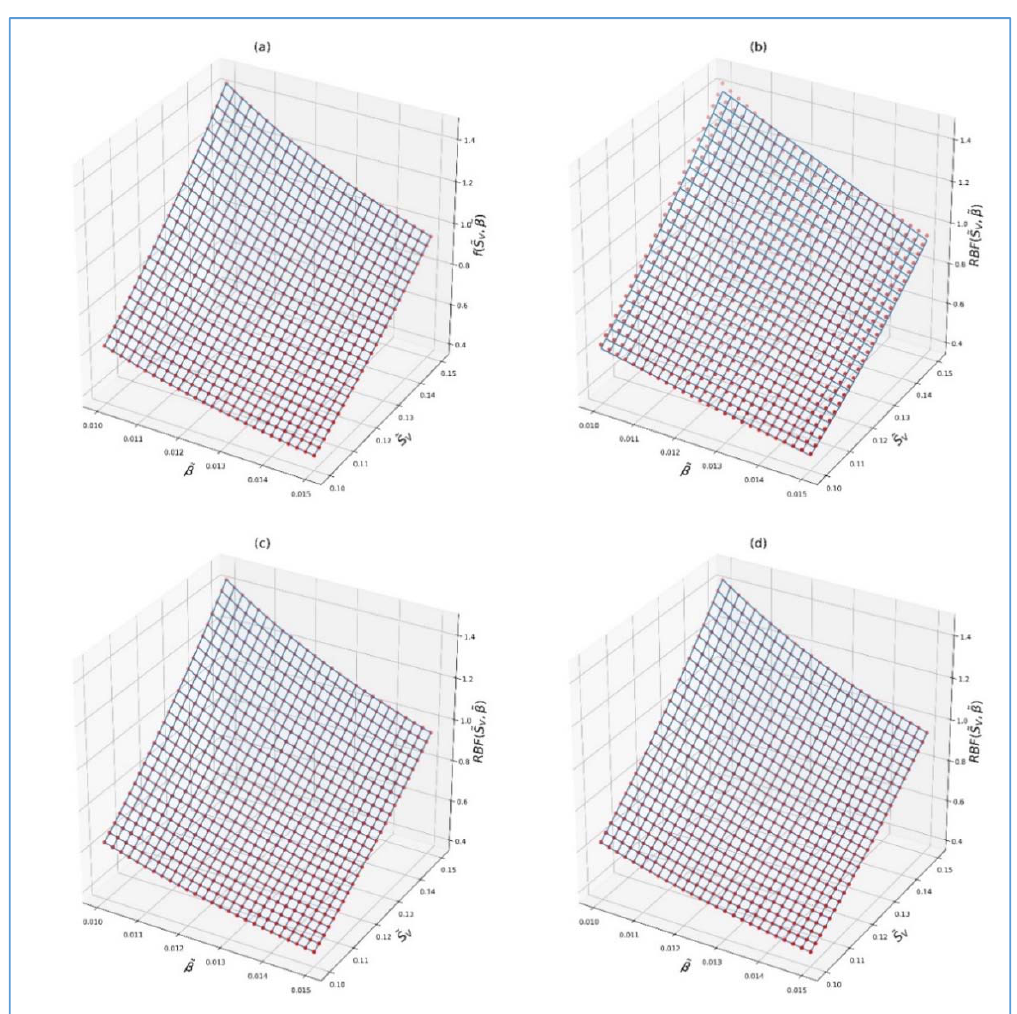
Figure 4. Visualization of the approximation surfaces obtained (blue wireframe), where original input dataset values are marked in red: ( a ) Original data, ( b ) surface mapped with 5 neurons, ( c ) surface mapped with 10 neurons, and ( d ) surface mapped with 15 neurons.